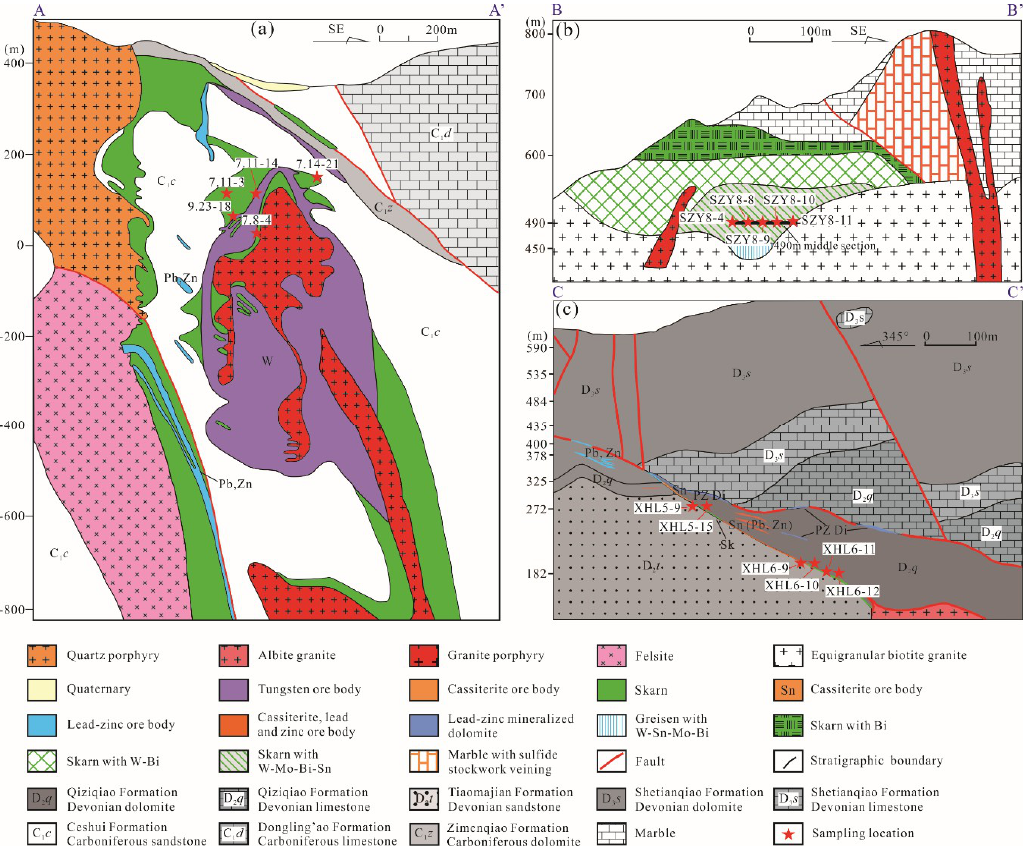
Figure 3. Cross-sections of ( a ) the Huangshaping deposit, ( b ) the Shizhuyuan deposit (modified from [11]); and ( c ) the Xianghualing deposit, respectively.